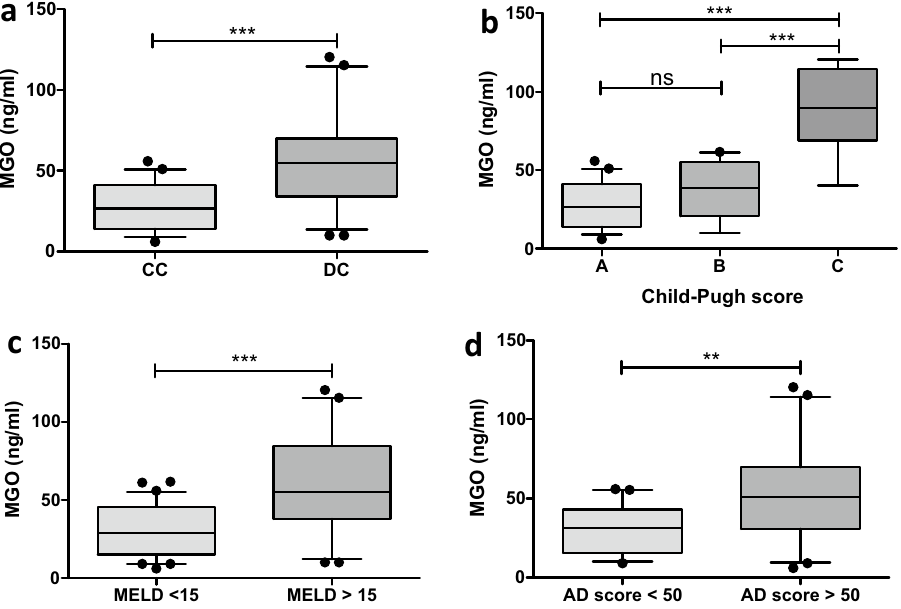
Figure 1. Whisker boxplots showing median (IQR 10th; 90th) MGO serum levels in patients with different liver disease severities. ( a ) The MGO levels were higher in patients with decompensated cirrhosis (DC). ( b ) Patients with Child–Pugh C showed higher levels than patients with Child–Pugh A and B. ( c ) MELD ≥ 15 showed increased MGO serum levels. ( d ) Patients with an acute decompensation (AD) score ≥ 50 presented with higher MGO levels. Differences between two groups were analyzed using the Mann–Whitney U test. More than two groups were analyzed by the Kruskal–Wallis test. The dots refer to values beyond the range of the 10th and 90th percentiles. *p < 0.05; **p < 0.01; ***p < 0.001; ns not